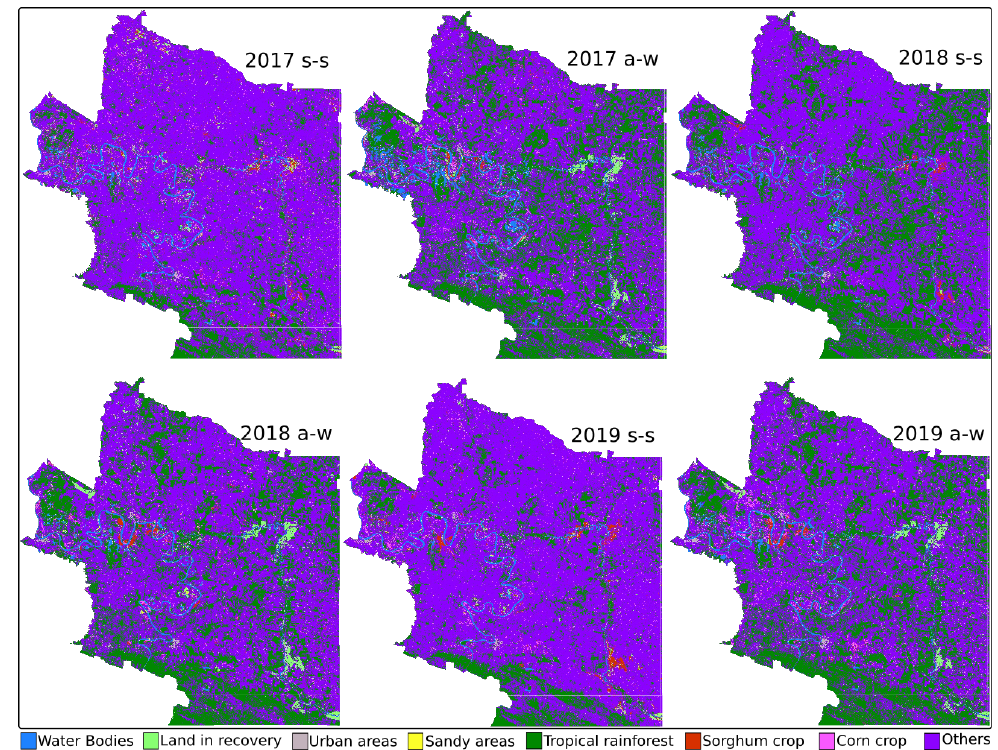
Figure 5. RF-generated maps. Table 8. Land-use coverage classified by RF. Coverage in